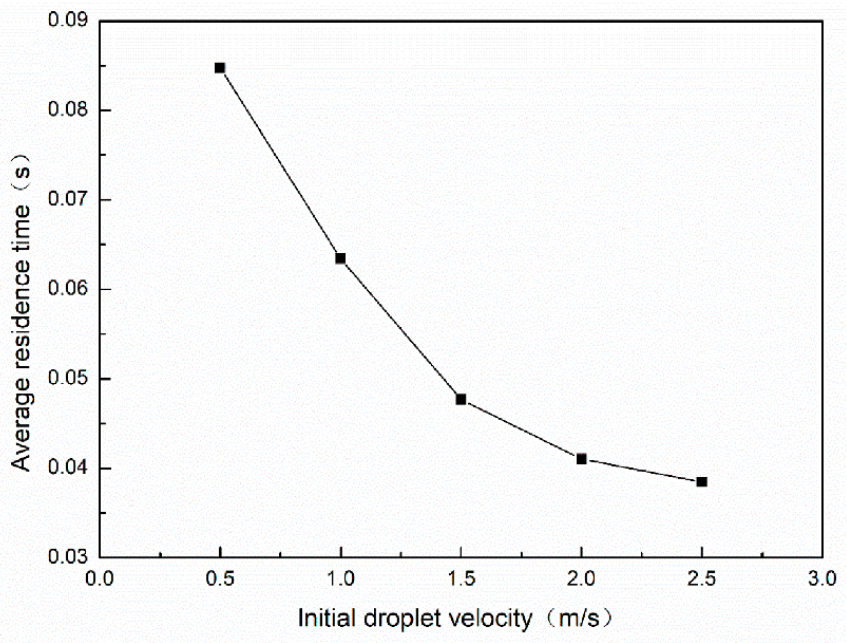
Figure 10. E ff ect of initial droplet velocity on average residence Figure 10. Effect of initial droplet velocity on average residence time.